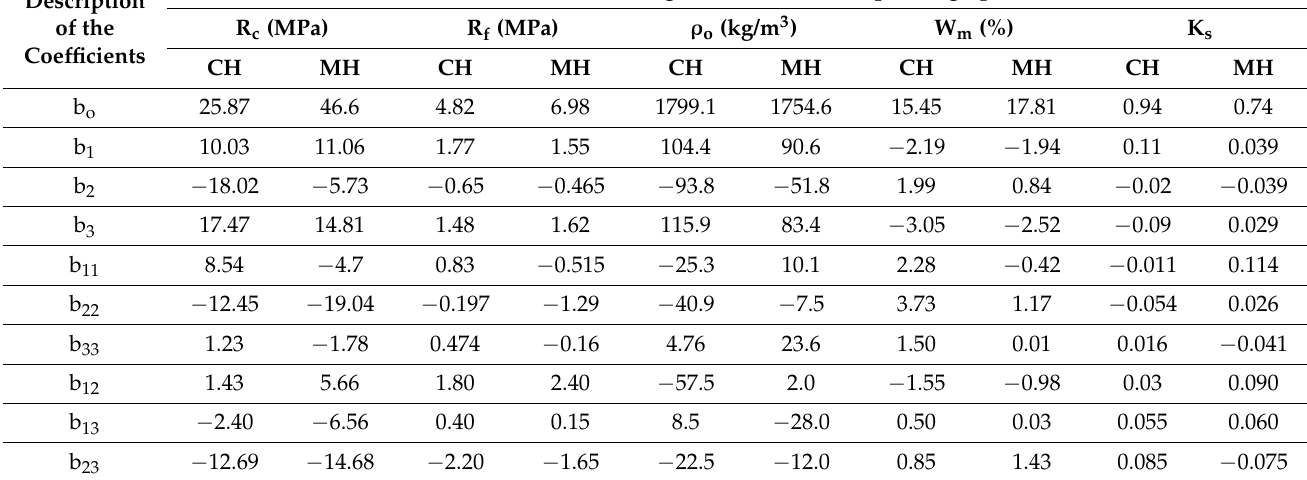
Table 6. The correlation coefficients for the ES-models of variation of the basic properties of the experimental samples were obtained immediately after the carbonisation (CH) and after a subsequent 28 days of hardening (MH). Description of the